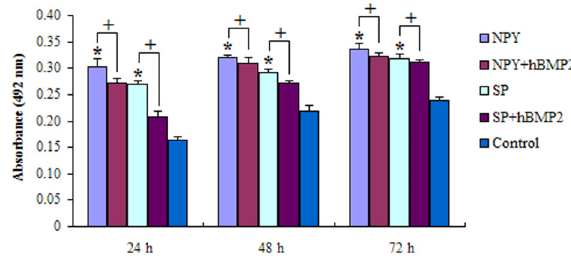
Figure 3. Cell viability of the effect of neuropeptides in combination with human bone morphogenetic protein 2 (hBMP2). It can be seen that the two neuropeptides [neuropep- tide Y (NPY) and substance P (SP)] induced statistically significant increases (*P , 0.05, compared to control; ANOVA) in cell viability, which rises over time, but the stimulating effect of neuropeptides decreased with the addition of hBMP2 ( + P , 0.05, ANOVA).